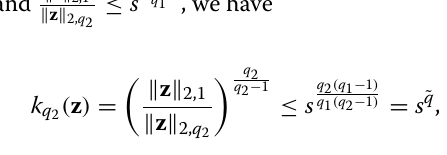
There are still some issues left for future work.